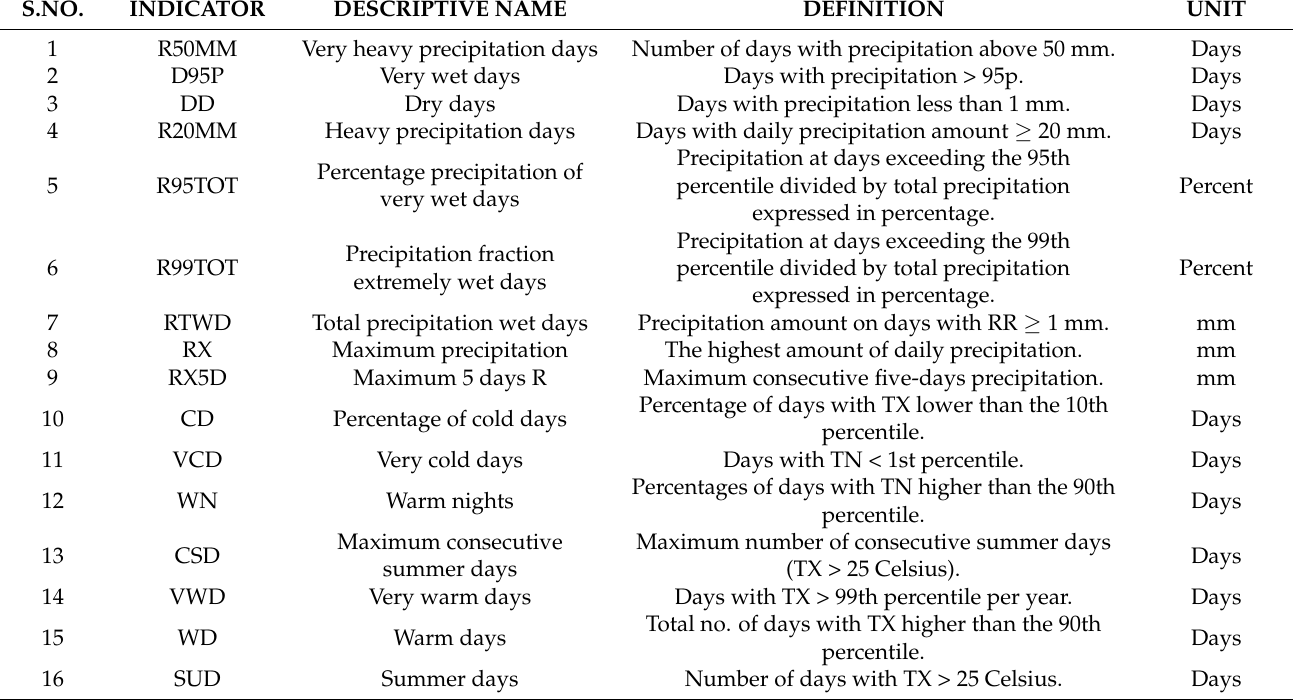
Table 1. Brief description of the Expert Team on Climate Change Detection and Indices (ETCCDI) used in the present study.